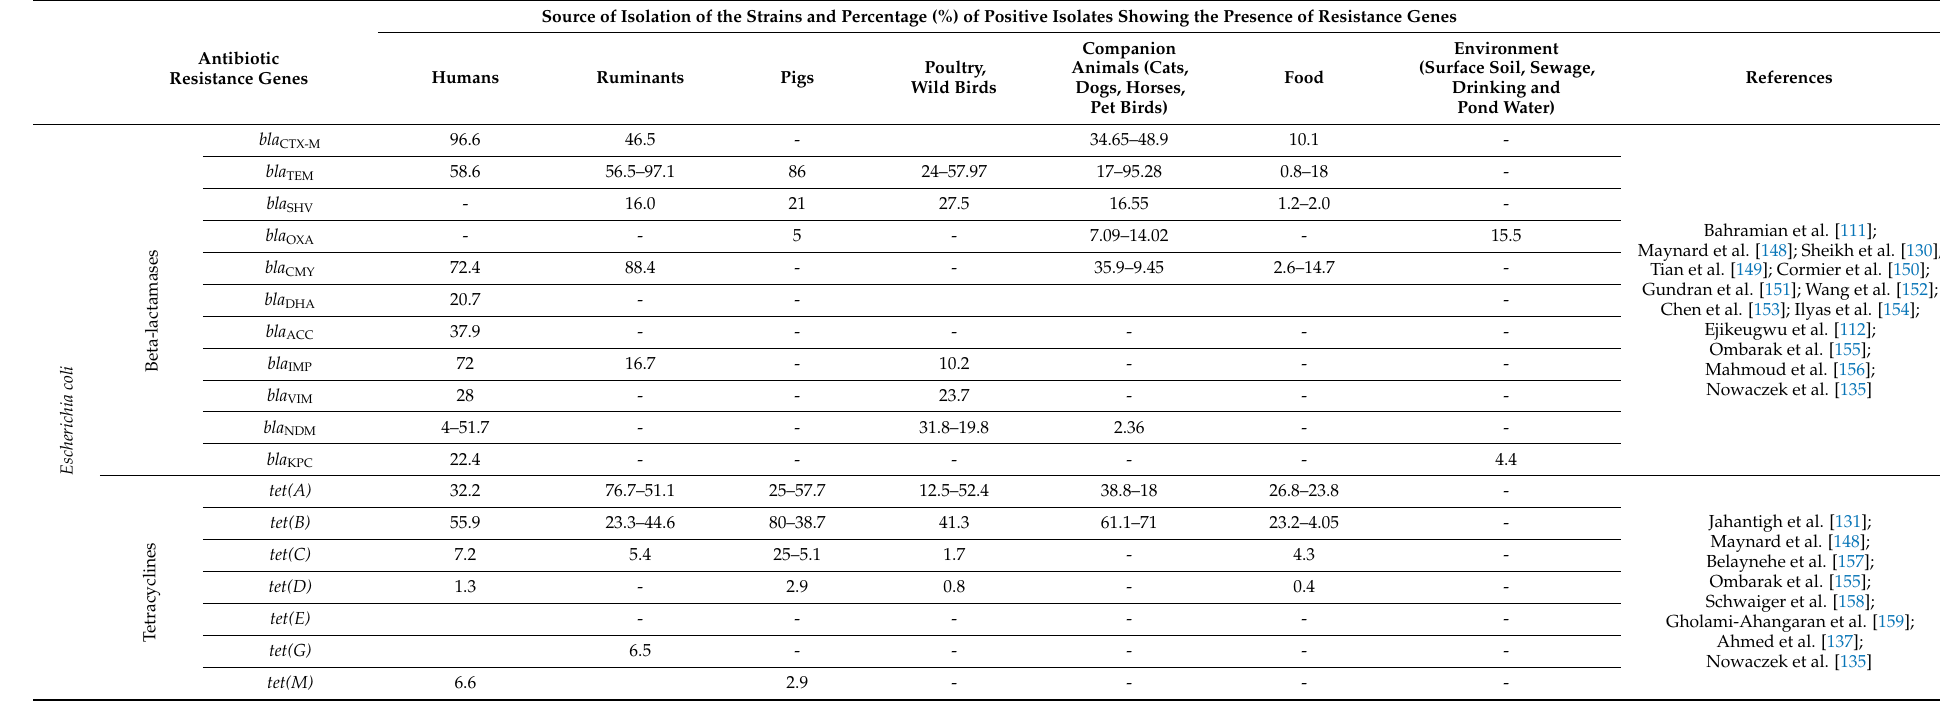
Table 2. The examples of the prevalence of antibiotic resistance gens in E. coli strains isolated from the environment and different animal species.